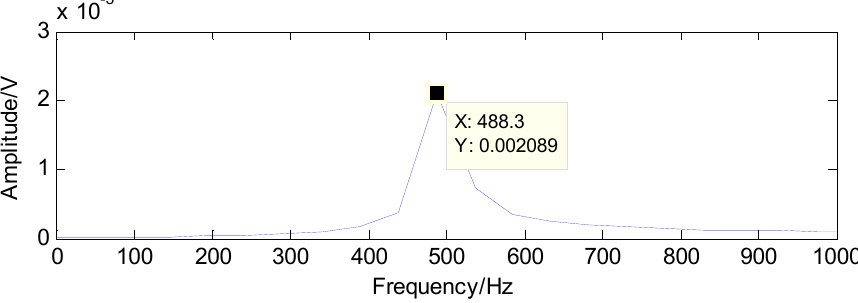
Figure 10. First detection result using the raw signals based on the method in [37].